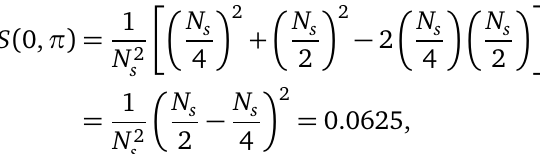
Figure 6: The four branches of energy spectrum corresponding to (a) W = t , and (c) W W 0